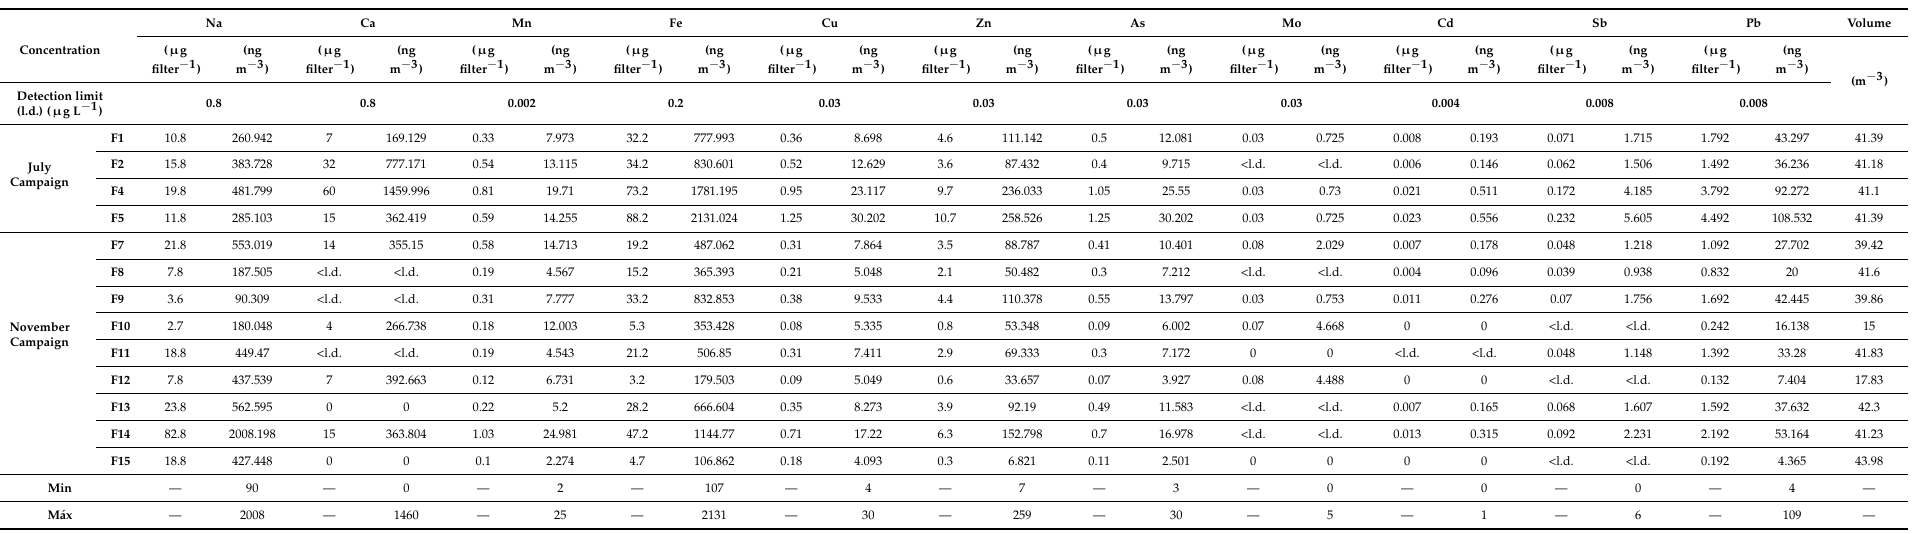
Table 2. Results of concentrations of the chemical elements analyzed by